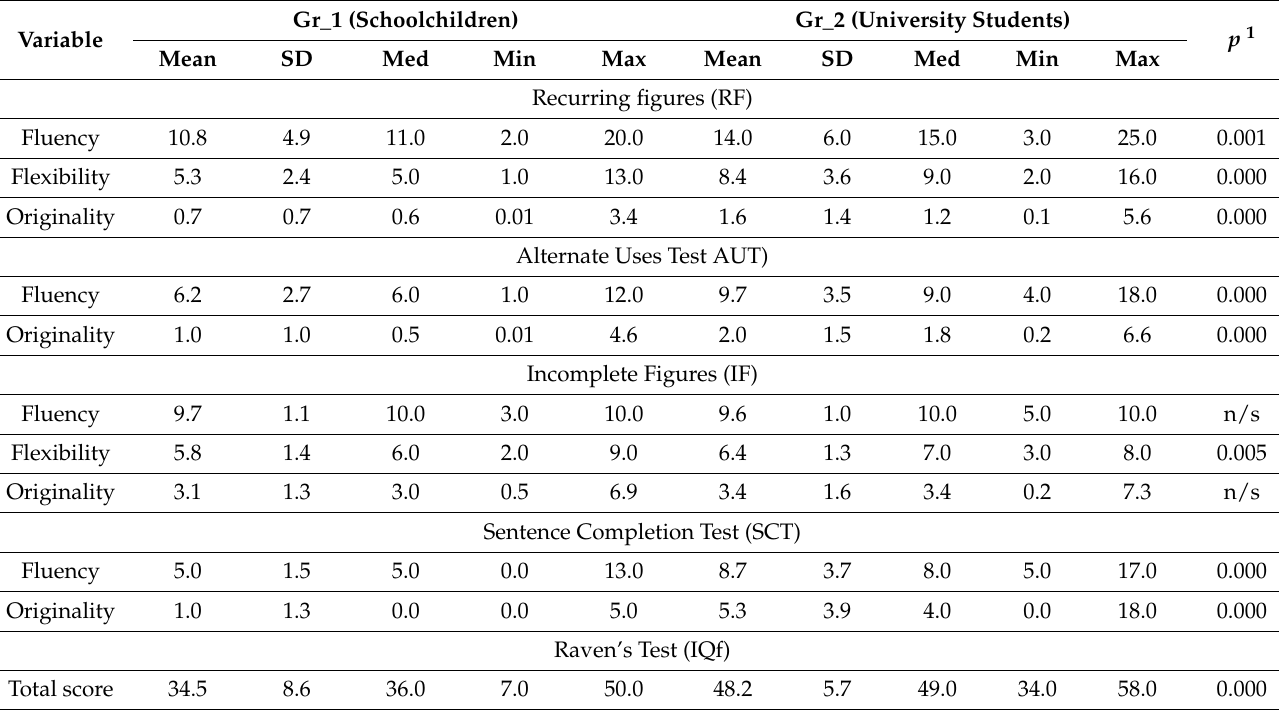
Table 1. The creativity indicators for the schoolchildren and the university students and their com- parisons.